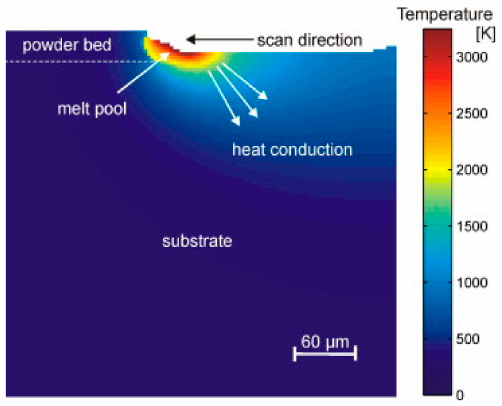
Figure 12. The thermal schematic of the AM process